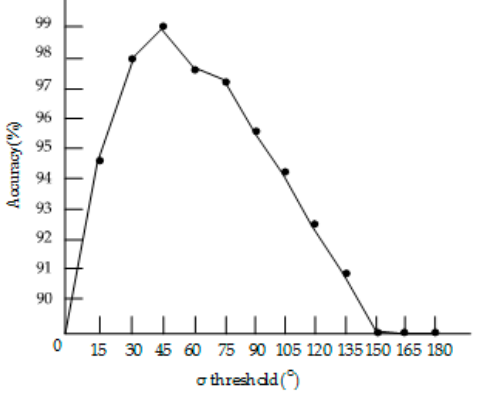
Remote Sens. 2020 , 12 , x FOR PEER REVIEW Figure 11. Setting of the angle constraint threshold σ . Figure 11. Setting of the angle constraint threshold σ .